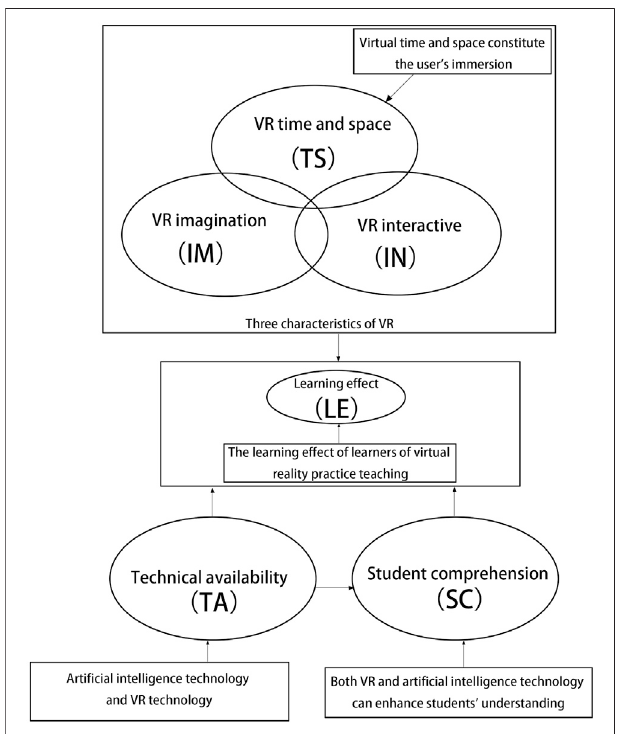
FIGURE 1 | Theoretical model of VR education methods to improve learning